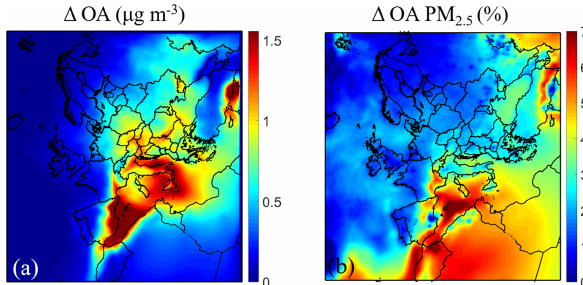
Figure 6. Ground level average (a) increase in PM 2 . 5 mass concen- tration of organics aerosol (in µgm − 3 ) and (b) fractional increase in PM 2 . 5 mass concentration of organics aerosol (%) due to the ad- dition of IVOCs emissions of semivolatile organic aging, predicted from 5 June–8 July. Different scales are